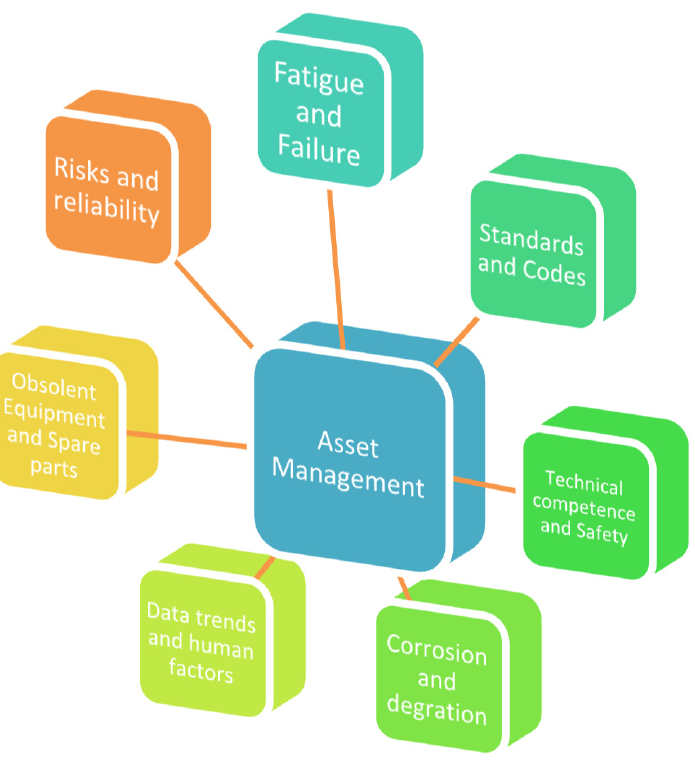
Figure 19. Different factors that are considered for maintenance management of offshore facilities.